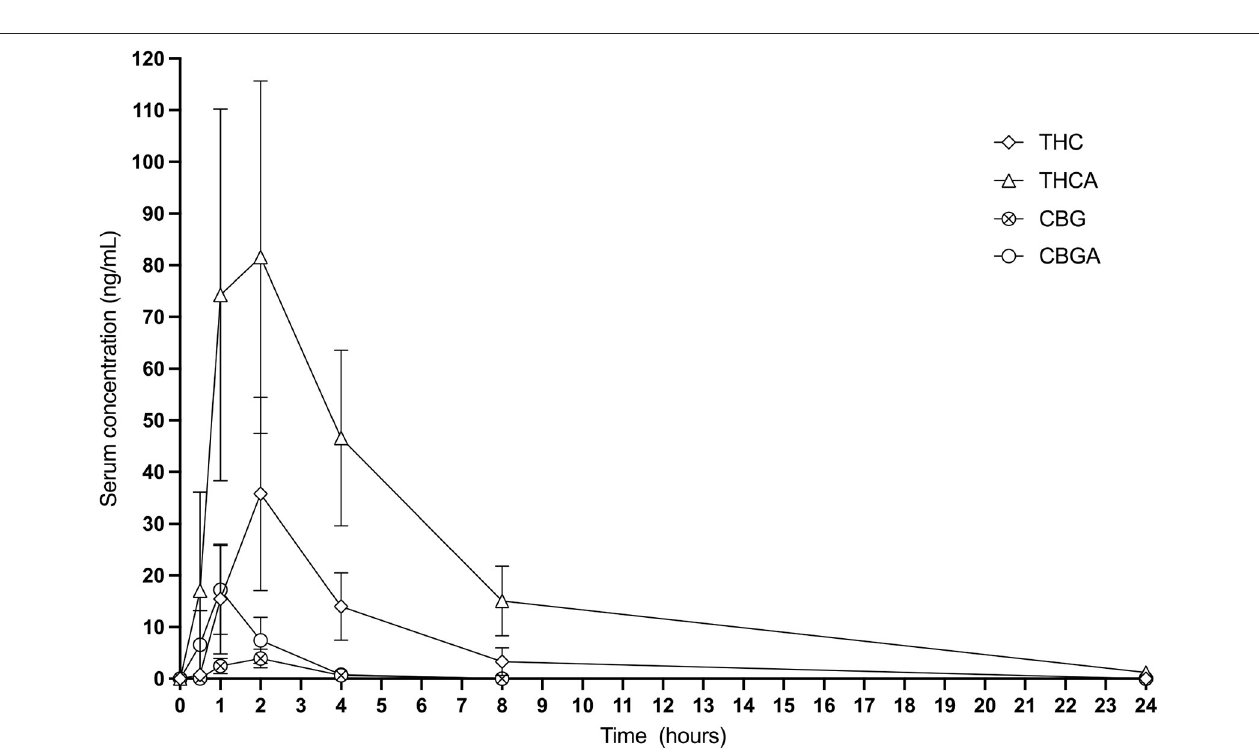
FIGURE 2 | Twenty-four hour graphic representation of THC, THCA, CBG and CBGA serum concentrations (mean and standard deviation at each time point).